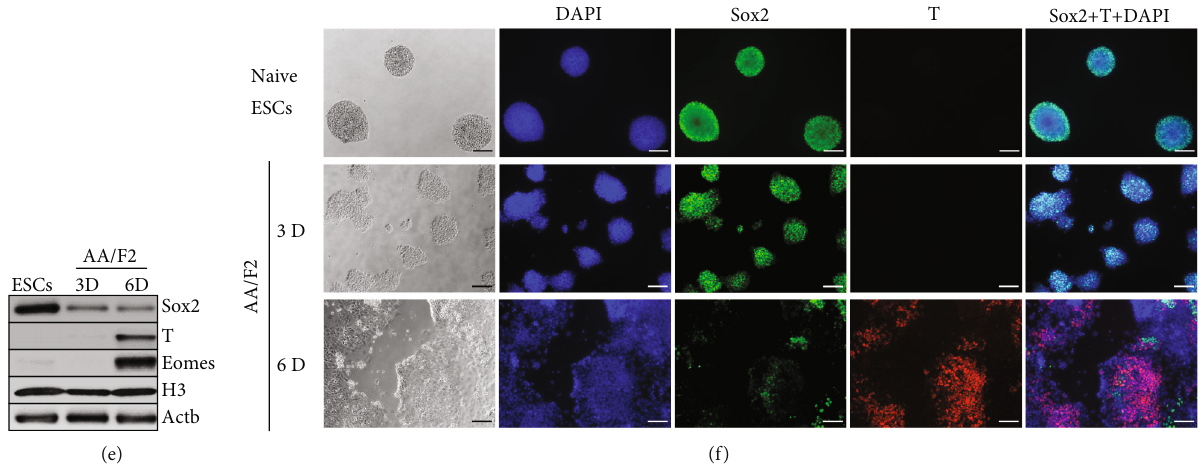
Figure 2: Human ESC/EpiSC culture condition matures the ESCs further to a primitive streak-like state. (a) Expression levels of the speci fi c pluripotency-associated genes in the indicated samples. AA/F2 treatment led to the induction of primed pluripotency genes and downregulation of PGC and naïve pluripotency genes. (b) Analysis of pluripotency genes in AA/F2-treated cells in the indicated samples. Gapdh and Pmm2 : housekeeping genes. Rex1 , Sox2 , and Nanog were downregulated, and Oct4 expression was retained. Error bars: mean ± SD ( n = 2 ); ∗ p ≤ 0 : 05 , ∗∗ p ≤ 0 : 01 , ∗∗∗ p ≤ 0 : 001 , and ∗∗∗∗ p ≤ 0 : 0001 ( p ð Rex1 Þ = 0 : 0107 , p ð Sox2 Þ = 0 : 0421 , and p ð Oct4 Þ = 0 : 0029 ) (Student ’ s t -test). (c) Heat map showing the expression status of lineage-speci fi c markers in the indicated samples in comparison with naïve mESCs. PS markers are induced in AA/F2-3 days (3D). (d) Analysis of EpiSCs ( Fgf5 ) and PS markers ( T and Fgf8 ) in the indicated samples. Fgf5 and Fgf8 were induced right from 1D, and by 6D, the PS marker T was also highly induced. Error bars: mean ± SD ( n = 3 ); ∗ p ≤ 0 : 05 , ∗∗ p ≤ 0 : 01 , ∗∗ p ≤ 0 : 001 , and ∗∗∗∗ p ≤ 0 : 0001 ( p ð Fgf8 Þ = 0 : 0070 and p ð T Þ = 0 : 0235 ) (Student ’ s t -test). (e) Western blot analysis of the indicated markers in the indicated samples. Six days of AA/F2 treatment led to high protein expression of the PS/mesendoderm markers T and Eomes and downregulation of Sox2. (f) Representative immunostainings of the indicated proteins in the indicated samples (scale bars 100 μ